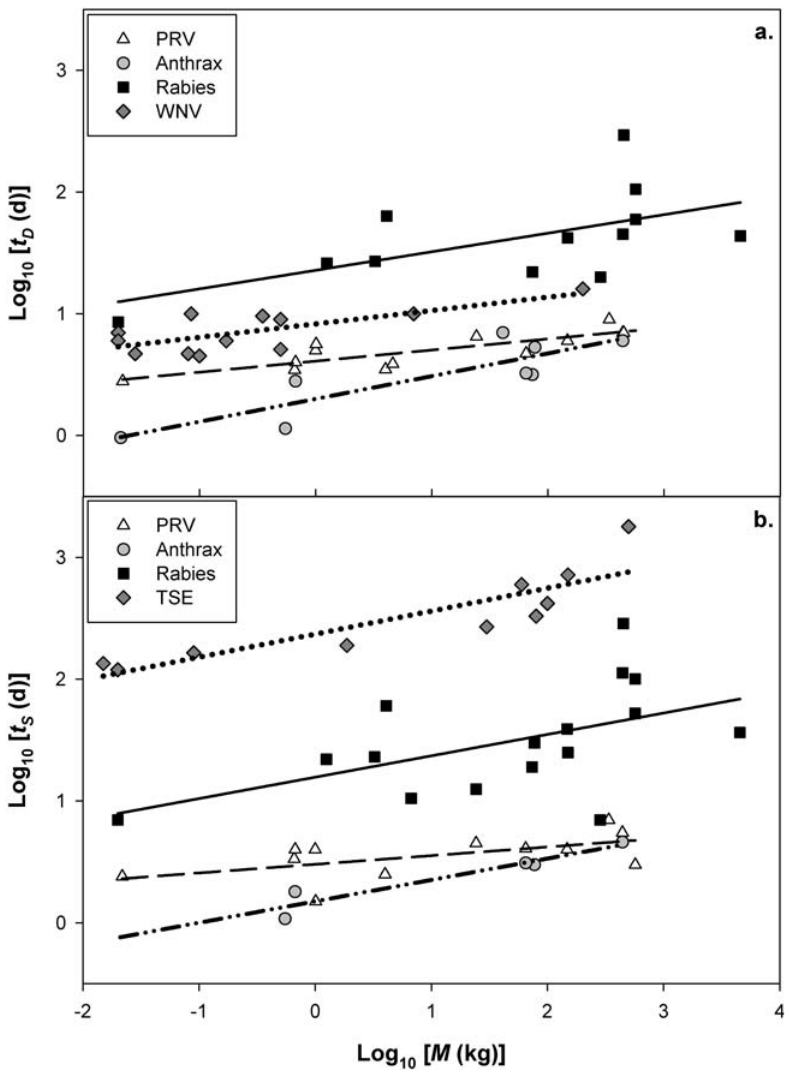
Figure 1. Time (days) from inoculation to (a) death and (b) 1 st symptom versus mammalian body mass for Pseudorabies virus (PRV), Anthrax, Rabies, West Nile Virus (WNV), and Transmissible Spongiform Encephalopathy (TSE).